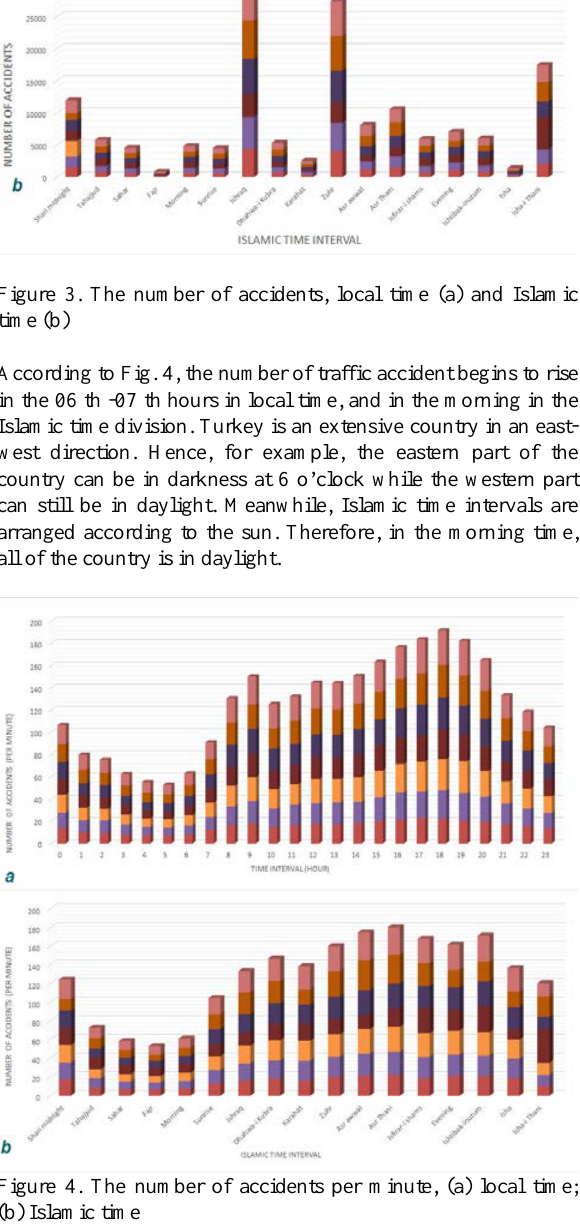
Figure 1. Traffic statistics in terms of years